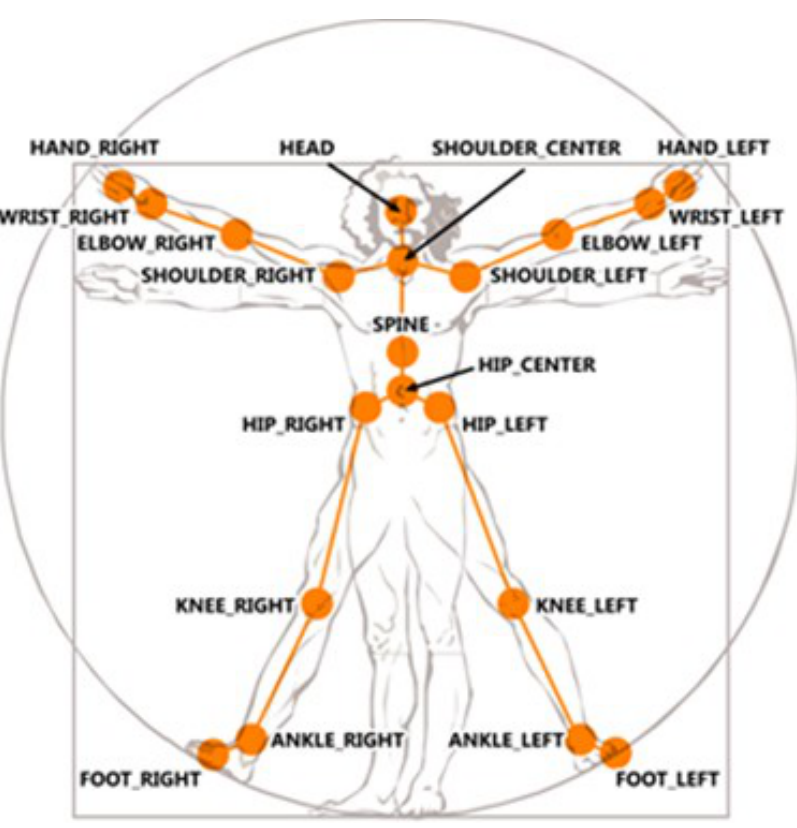
Figure 4. Joints captured by Kinect TM skeletal